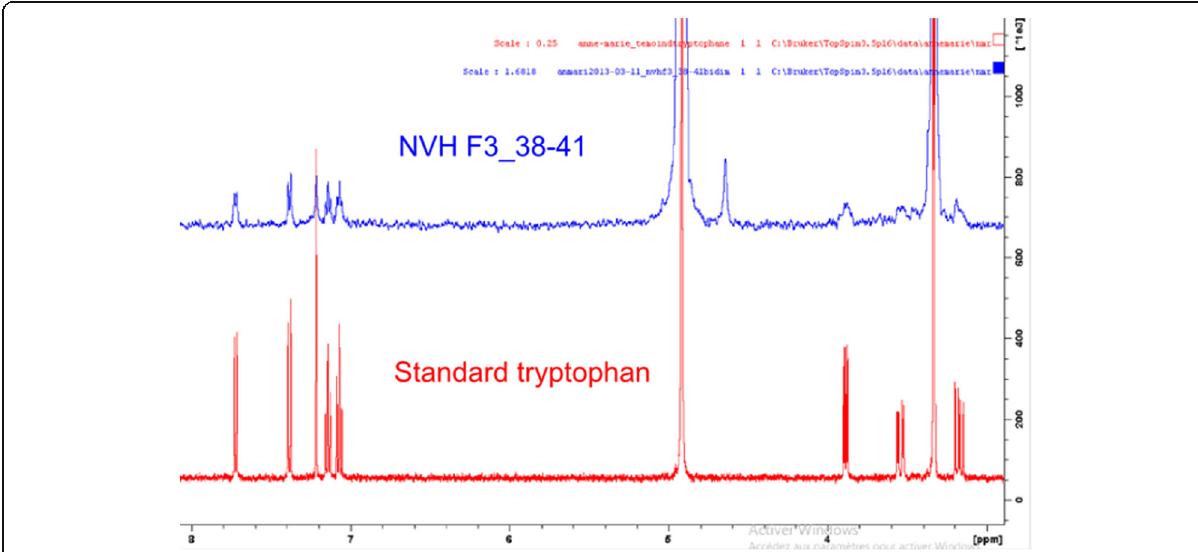
Fig. 4 Tryptophan identification from F3 fraction. In blue: NVH F3_38 – 41, a compound isolated from F3 fraction; In red: standard tryptophan. The isolated compound from F3 fraction has been compared to tryptophan by NMR